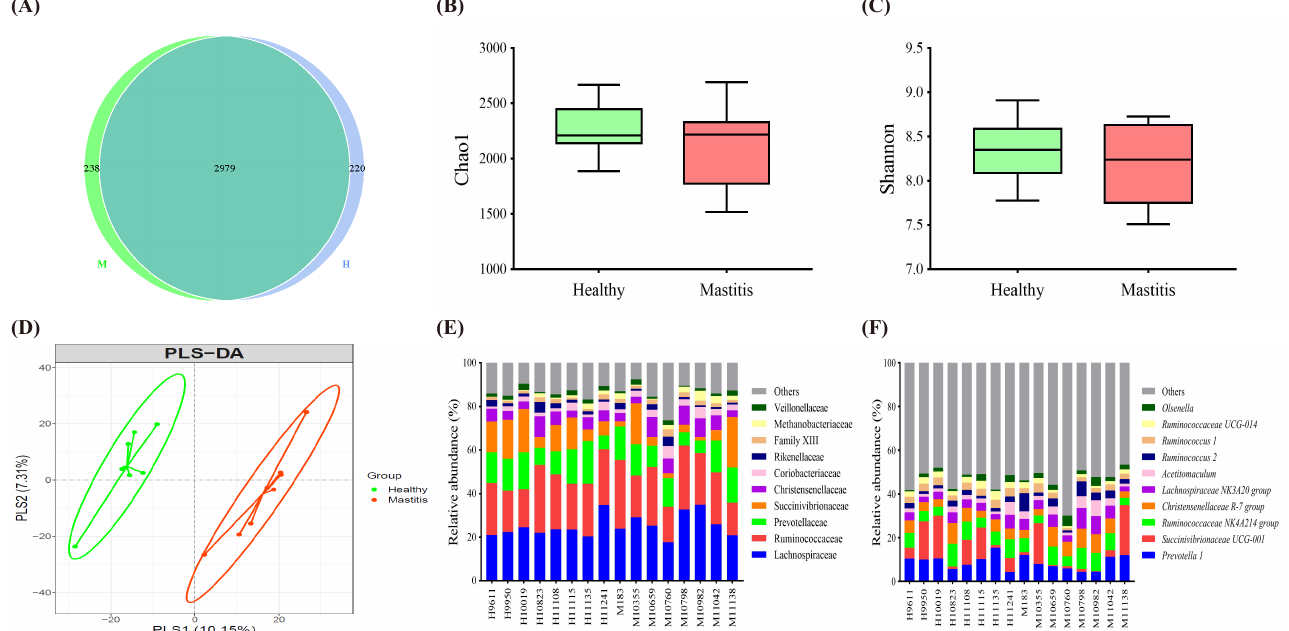
Figure 2. Ruminal bacteria and archaea composition identified by 16S rRNA sequencing of healthy and mastitic cows. ( A ) Venn diagram illustrating 2979 OTU of core microbiota identified by 16S rRNA sequencing of healthy (H) and mastitic (M) cows. ( B ) The Chao1 richness estimator and ( C ) Shannon’s diversity index. ( D ) Partial least squares discriminant analysis (PLS-DA) plot based on the relative abundance of OTUs indicates a significantly different composition of healthy versus mastitic cows. Ellipses represent 95% confidence intervals for each group. The top 10 ( E ) families and ( F ) genera identified in cow ruminal fluid, each bar refers to an individual